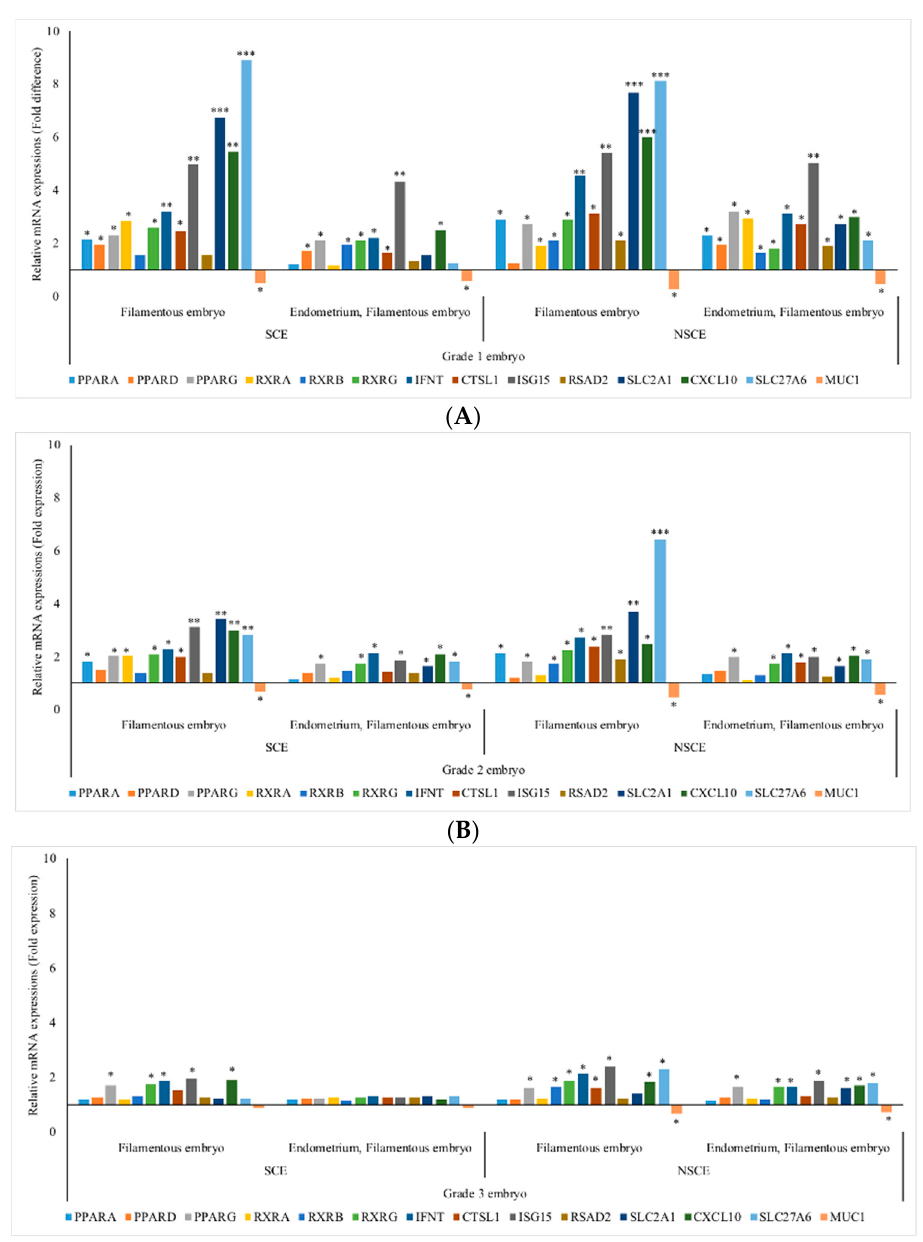
Figure 3. mRNA abundances (mean ± SEM) in gestational day (GD) 16 filamentous 1 conceptuses (compared to tubular conceptuses § ) and corresponding endometrium (compared to endometrium that yielded tubular 1 conceptuses § ) from repeat breeder cows 2 with or without subclinical endometritis 3 following transfer of GD 7 embryo Quality Grade 4 (QG) 1 ( A ), embryo Grade 2 ( B ) and embryo Grade 3 ( C ). * p < 0.05; ** p < 0.01; *** p < 0.001; § Reference group, relative mRNA expression is equal to 1 fold; 1 Filamentous conceptus, ≥ 25 mm long; Tubular conceptus, 10 to 20 mm long; 2 Repeat breeder cows were with the history of failing to conceive after the first three inseminations post calving and with the history of at least one pregnancy loss between 30 and 60 days after any of the first three services during the second or third lactation; 3 Cows with subclinical endometritis, >6% PMN on endometrial cytology; cows without subclinical endometritis, ≤ 6% PMN on endometrial cytology; 4 Embryo QG: Codes 1 to 4; 1, excellent/good; 2, fair; 3, poor; 4, unfertilized/dead/degenerate); PPAR —peroxisome proliferator-activated receptor; RXR —retinoid X receptor; IFNT —interferon- τ ; CTSL1 —Cathepsin L 1; ISG15 —interferon-stimulated gene-15; RSAD2 —Radical S-Adenosyl Methionine Domain Containing 2; SLC2A1 —Solute Carrier Family 2 Member 1; CXCL10 —C-X-C Motif Chemokine Ligand 10; SLC27A6 —Solute Carrier Family 27 Member 6; MUC1 —Mucin